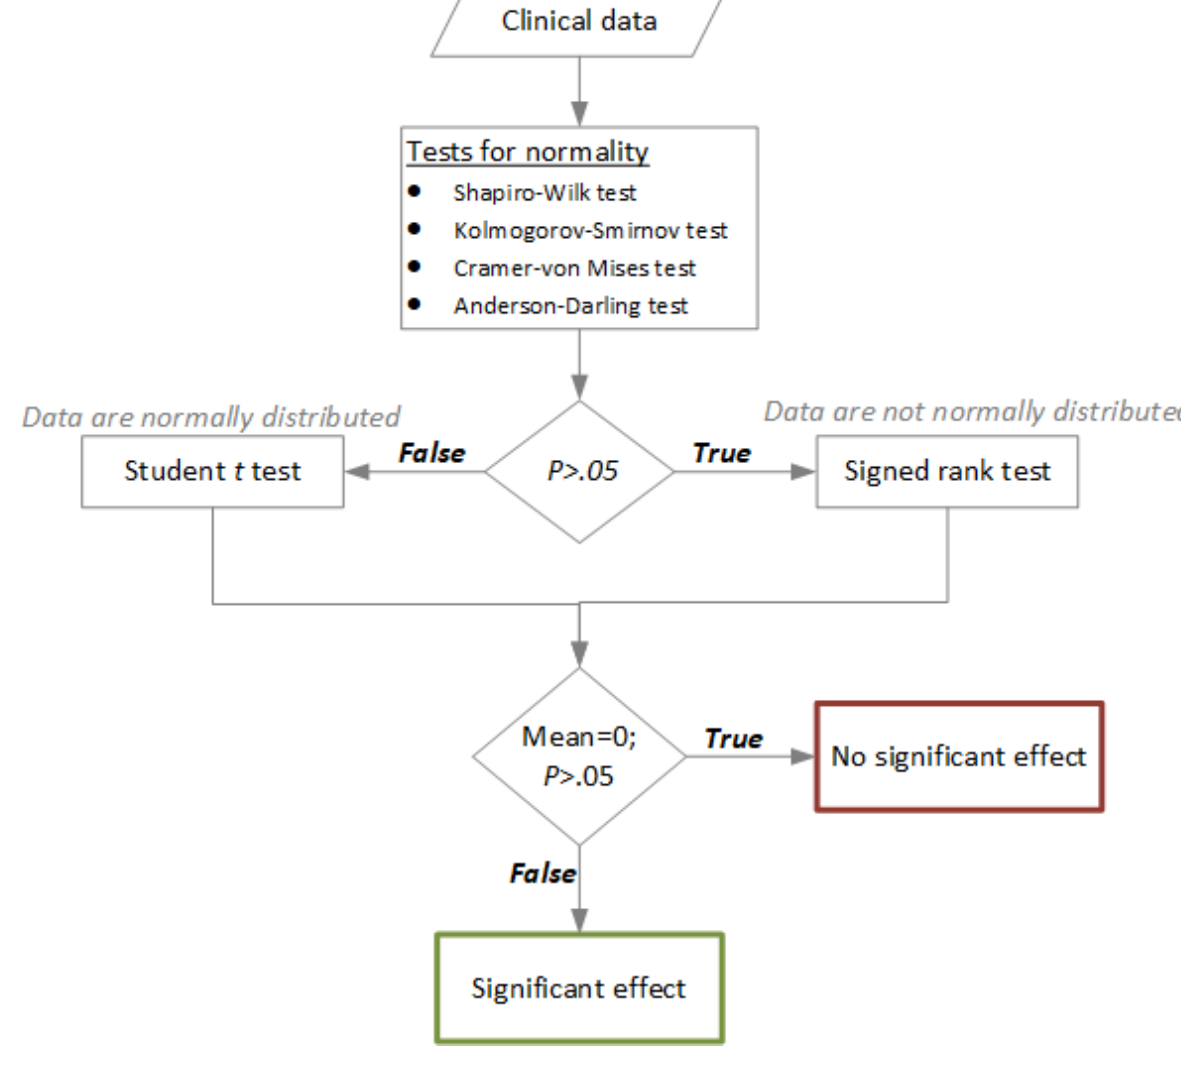
Figure 3. Flowchart showing the statistical analysis process to evaluate the effect of HeartHab on various health